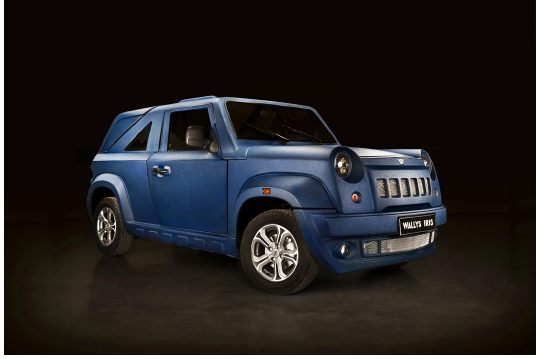
Figure 5. The Iris, presented